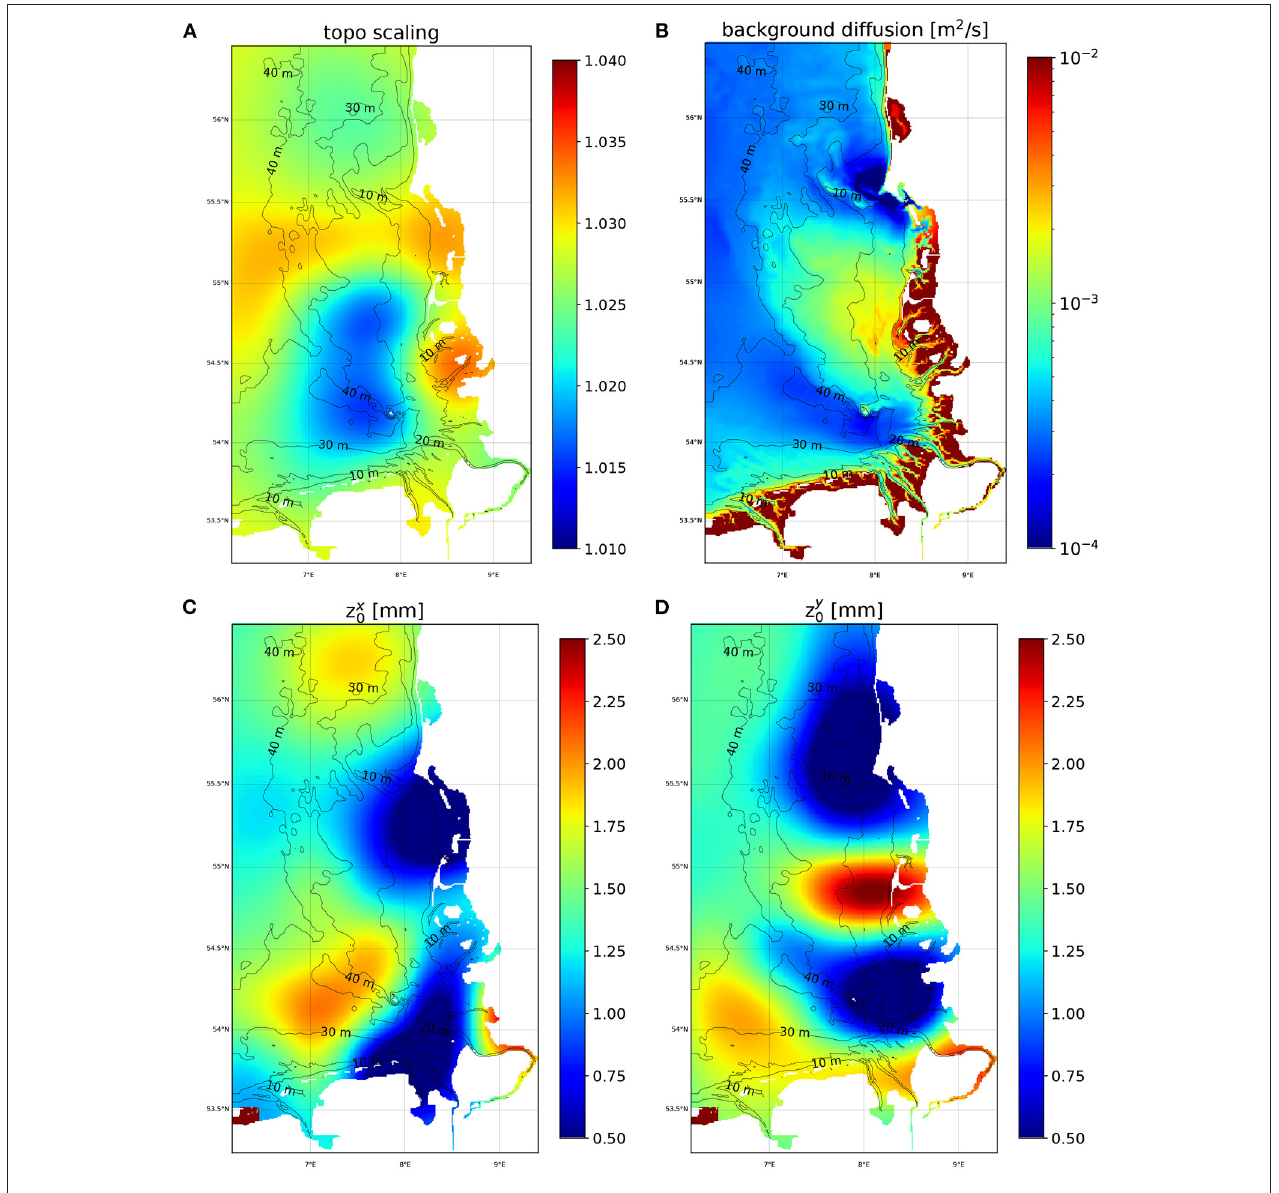
FIGURE 10 | (A) Correction of water depth by the 4DVAR scheme. (B) Background vertical momentum diffusion map estimated by the 4DVAR scheme. (C,D) Maps of zonal (C) and meriodional (D) components of bottom roughness estimated with the 4DVAR scheme.